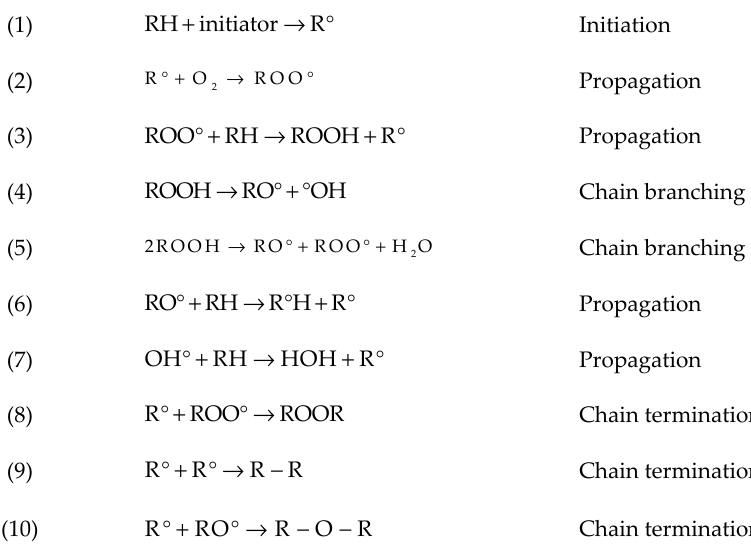
Figure 4. Overview on hydrocarbon oxidation reactions [16]. RH, polymer; ROO°, peroxy radical; ROOH, hydroperoxide; RO°, alkoxyl radical; °OH, hydroxyl radical.